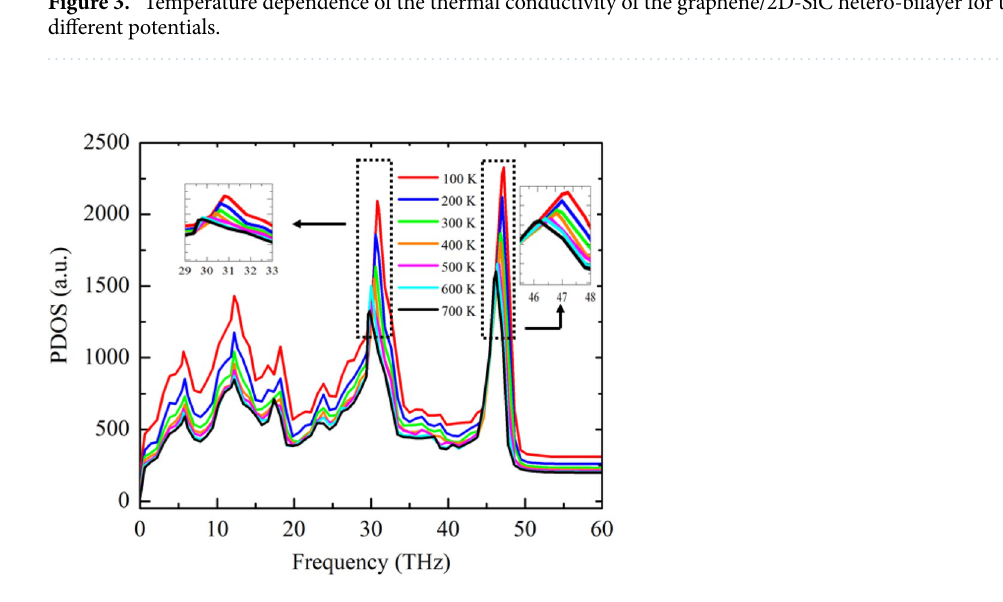
Figure 4. Effect of temperature on the in-plane phonon density of states